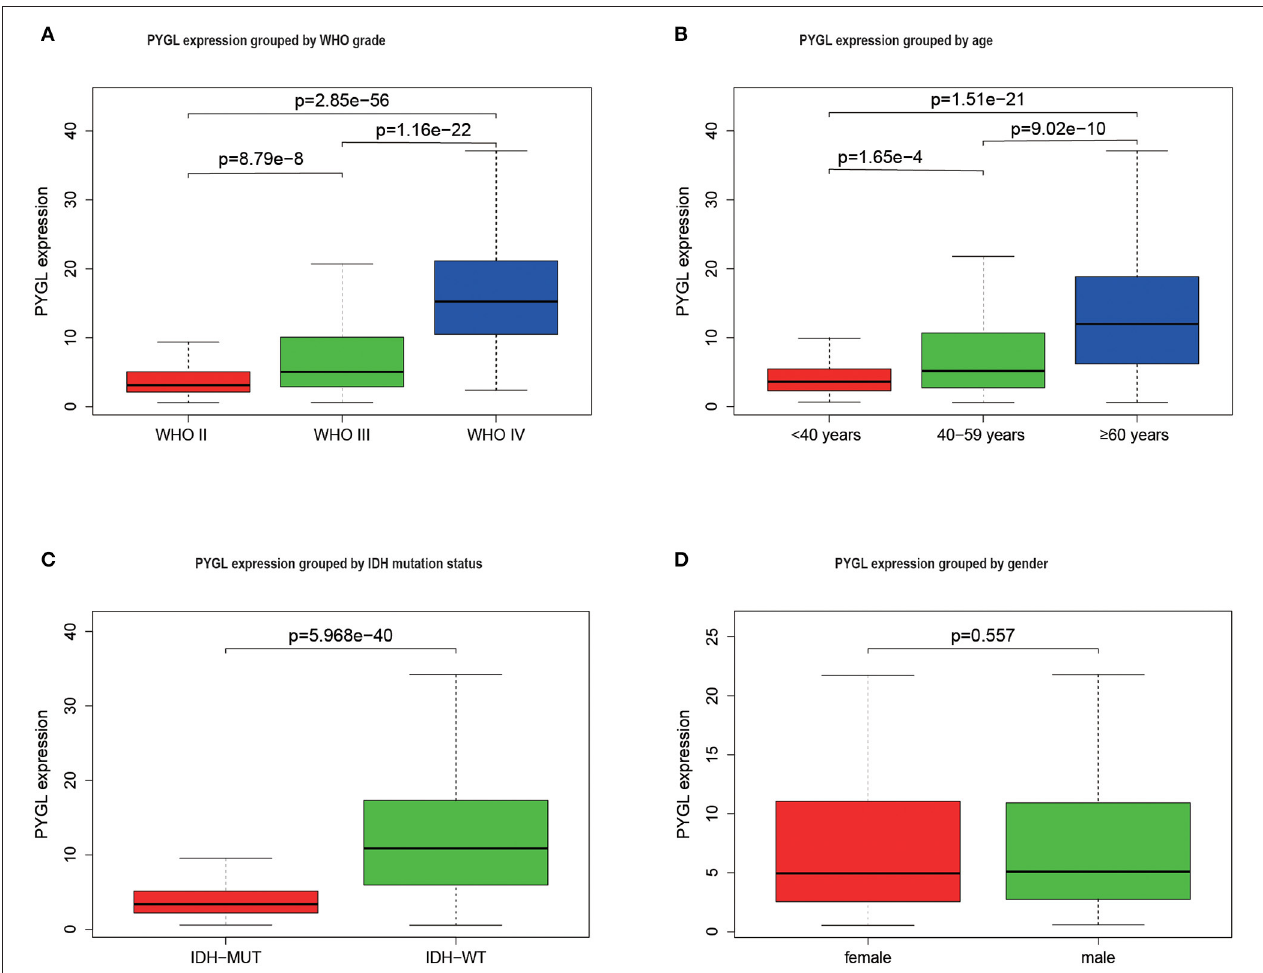
FIGURE 1 | PYGL expression in glioma. (A) PYGL expression at different malignant grade categories. (B) PYGL expression at different age categories. (C) PYGL expression at two IDH mutation status groups. (D) PYGL expression at two sex categories.